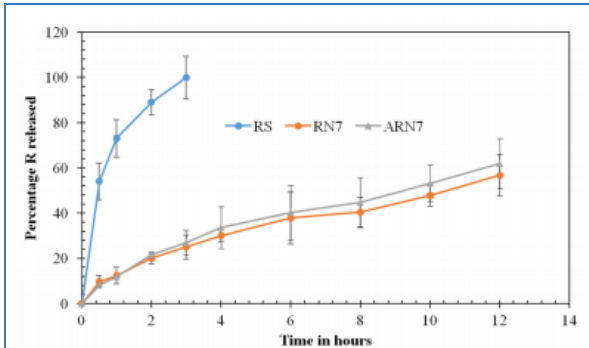
Figure 5. In-vitro rapamycin drug release profile in rapamycin solution (RS), nanoemulsion (RN7), and nanoemulsion conjugated with albumin (ARN7). Adapted with permission [109].